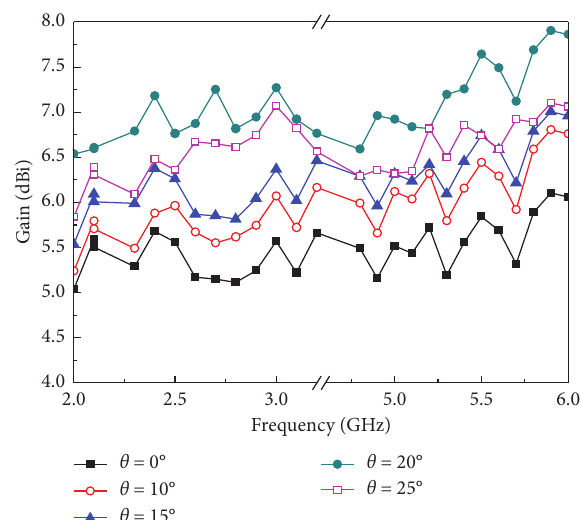
Figure 8: The simulated gain for different θ